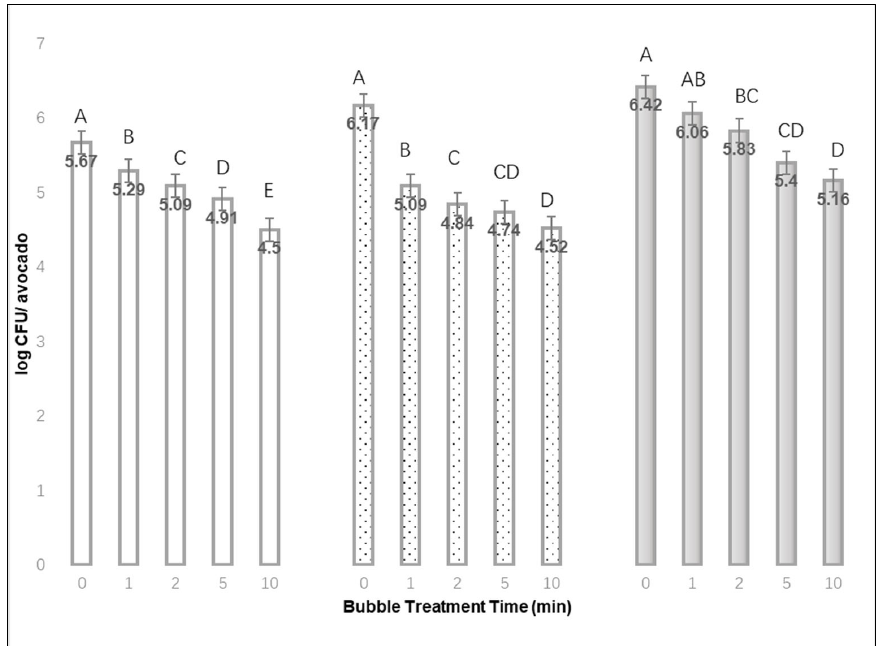
Figure 3. The mean log CFU L. monocytogenes recovered per avocado after inoculum drying times of 1 h , 24 h , or 48 h , and different bubble treatment times from 0 to 10 min (mean of 3 replications x 3 samples each). A,B,C,D,E Denote significant differences in recovery ( p < 0.01) between treatment times for each of the inoculum drying times.